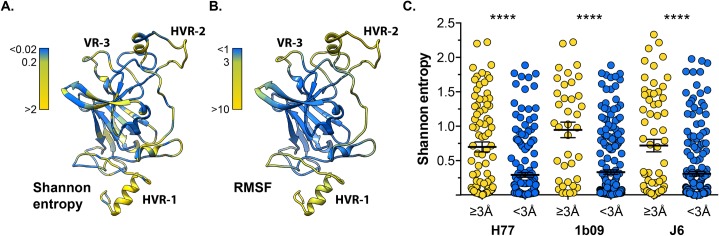
Variable regions exhibit high flexibility.Shannon entropy provides a measure of diversity with high values indicating low conservation. A. H77 E2 model color-coded for Shannon entropy; variable regions have high values. B. H77 E2 model color-coded for RMSF; variable regions exhibit high flexibility. C. E2 residues from H77, 1b09 and J6 were classified being in regions of high flexibility (RMSF ≥3Å) or low flexibility (RMSF <3Å). For each strain, residues within regions of high flexibility exhibited significantly higher Shannon entropy (Mann-Whitney test, p <0.0001, GraphPad Prism). Shannon entropy was calculated using E2 protein alignments for HCV genotype 1 (H77 and 1b09) and 2 (J6).